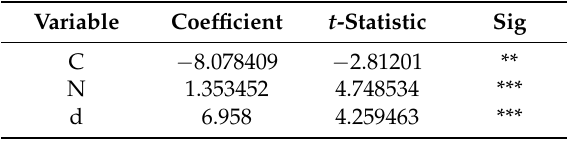
Table 3. The tables of the parameters for regression.